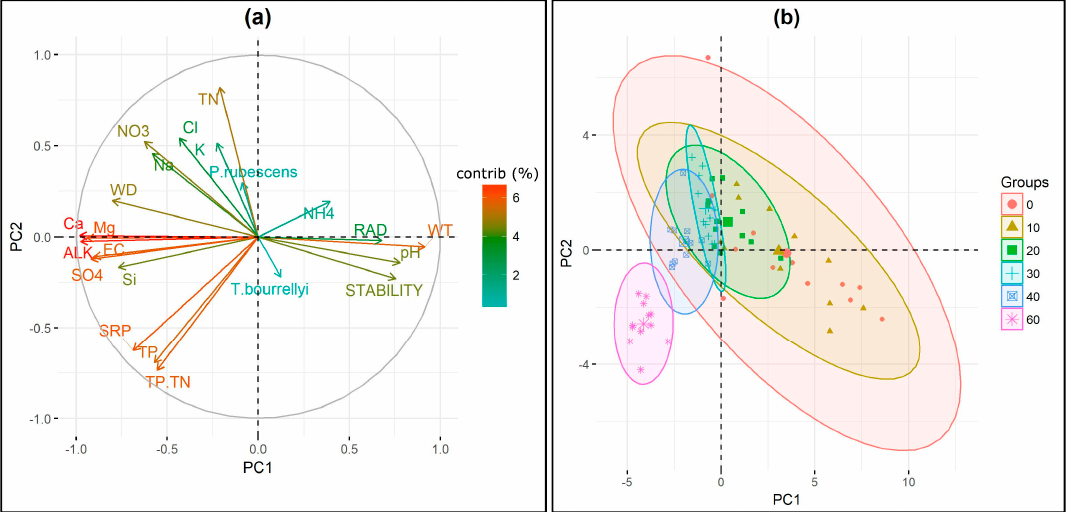
Figure 6. Preliminary principal component analysis (PCA) performed on biovolume values of P. rubescens and T. bourrellyi and 20 chemico-physical variables, detected during the whole period analyzed from the surface to a depth of 60 m. ( a ) Loading plot on the plane defined by principal components 1 (PC1) and 2 (PC2), with different colors according to the individuals’ contributions (“contrib %”). See “Materials and Methods” for the abbreviations; ( b ) Score plot on the plane defined by PC1 and PC2; samples are grouped (“Groups”) by different depths in ellipses (confidence level 0.95).